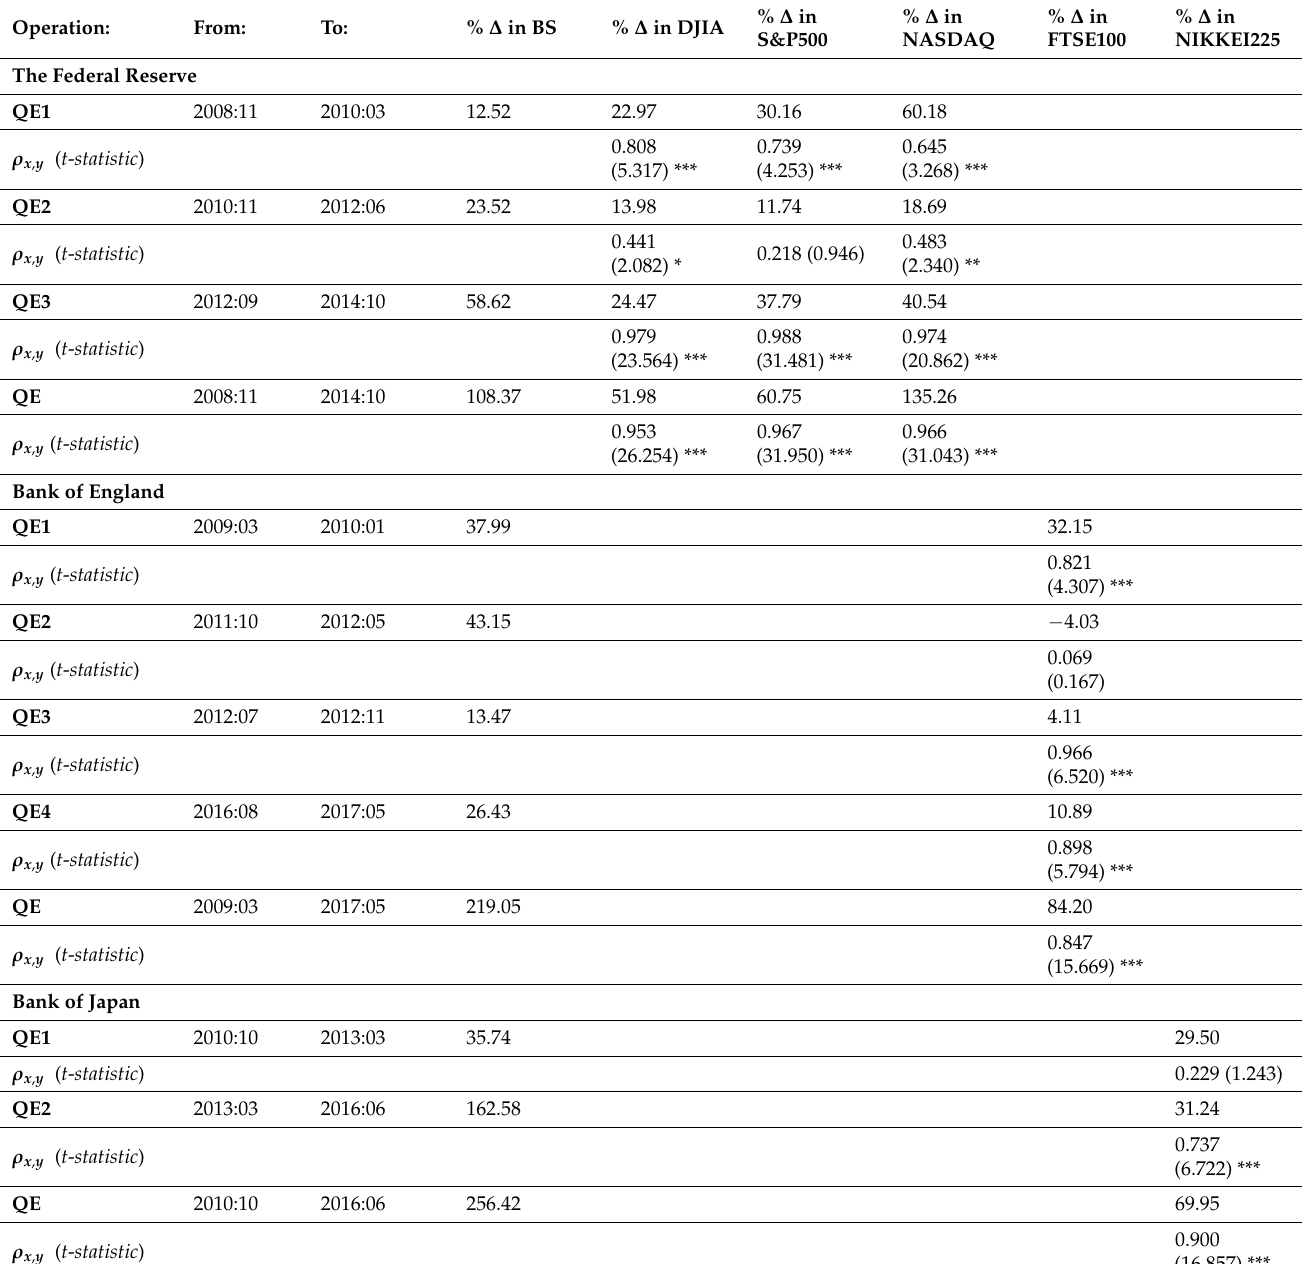
Table 1. Changes in Balance Sheets of Central Banks and Stock